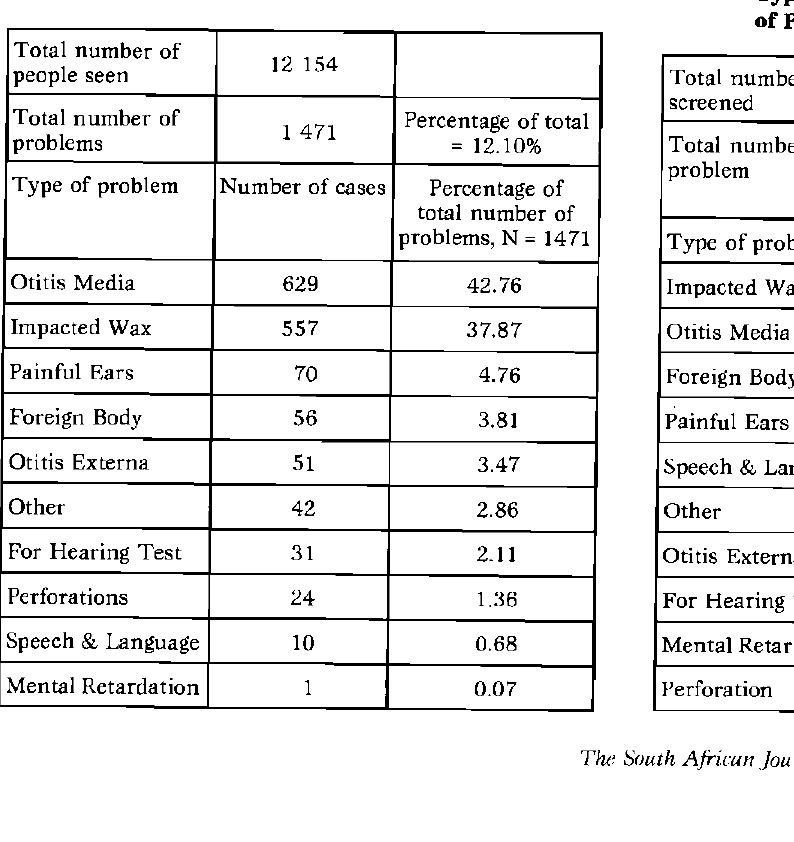
Table 2: Types of Problems and their Percentage Relative to the Total Number of Problems Seen at the Out- Table 3: Total Number of Problems seen at 38 Schools (4 Hospitals) and the Percentage of the Different Types of Problems Relative to the Total